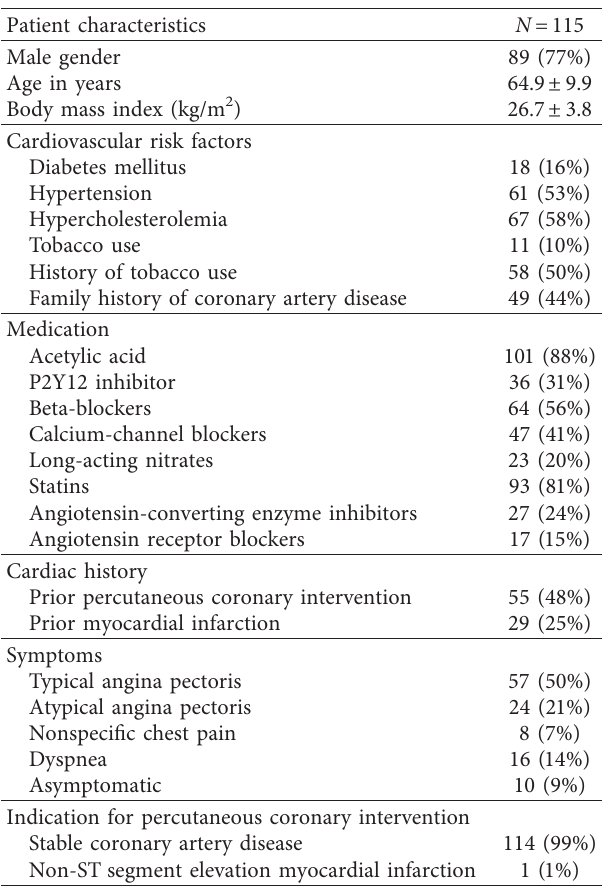
Figure 2: Flowchart of patients and vessels that were included and excluded. AUC, area under receiver operating characteristic curve; FFR, fractional flow reserve; PCI, percutaneous coronary intervention; QFR, quantitative flow ratio; ICA, invasive coronary angiography. Table 1: Patient characteristics. Table 2: Angiographic